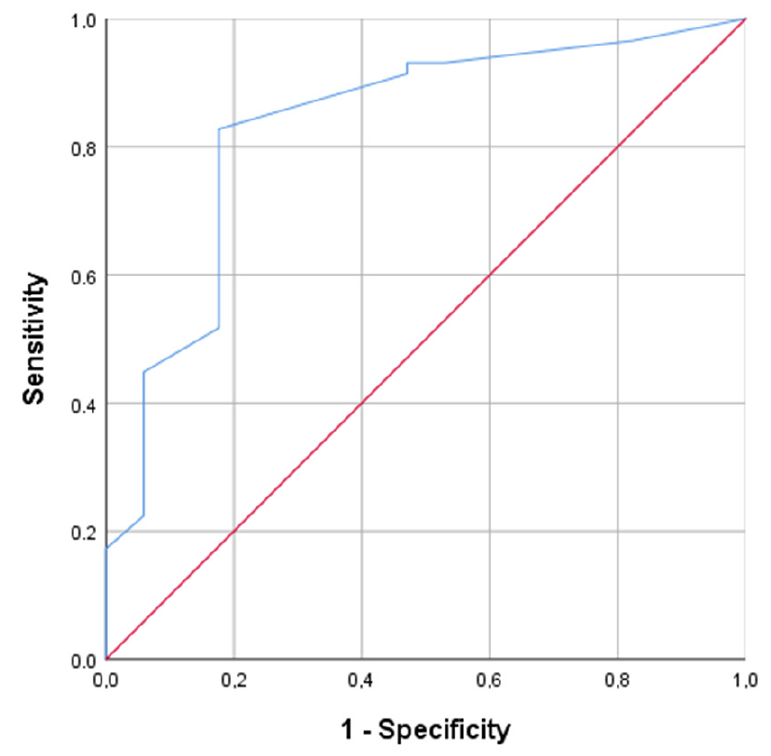
Figure 1. Receiver-operating-characteristic (ROC) curve of the size of a non-invasive pituitary adenoma for predicting CD remission one year after TSS. The optimal cutoff of corticotropinoma size for predicting CD remission after TSS was ≥ 3 mm, with the sensitivity 82.8% and the specificity 82.4% ( p < 0.001, AUC = 0.832, 95% CI = 71.5–94.8%).